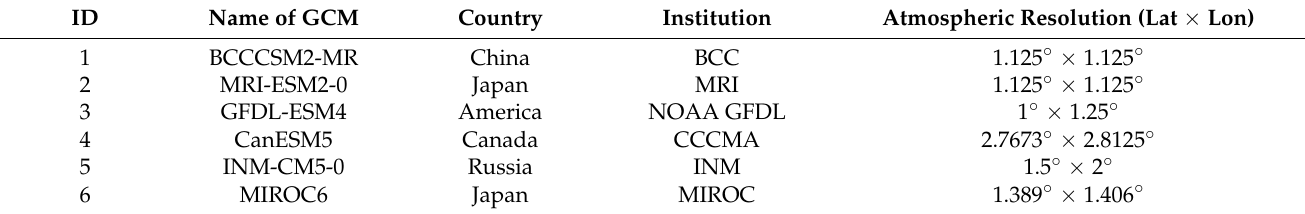
Table 1. The details of 5 GCMs used in